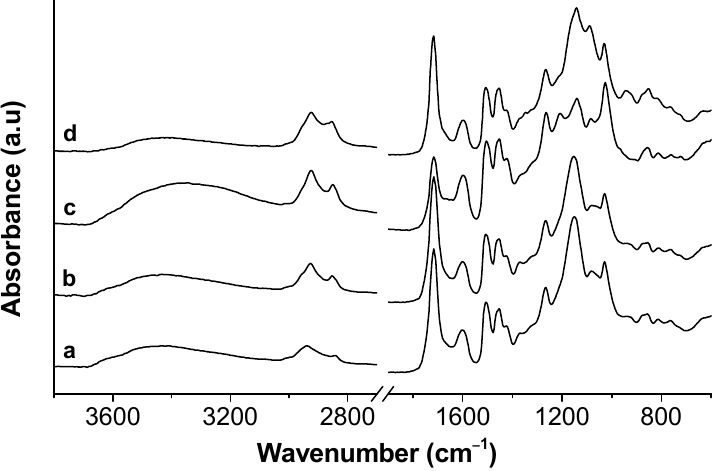
Figure 8. Normalized FTIR spectra of lignin obtained after extraction with (a) formic acid and 0.01 mol L − 1 of (b) SDS, (c) CTAB, and (d) PS20. The thermal decomposition profiles of the recovered lignins are shown in Figure 9.